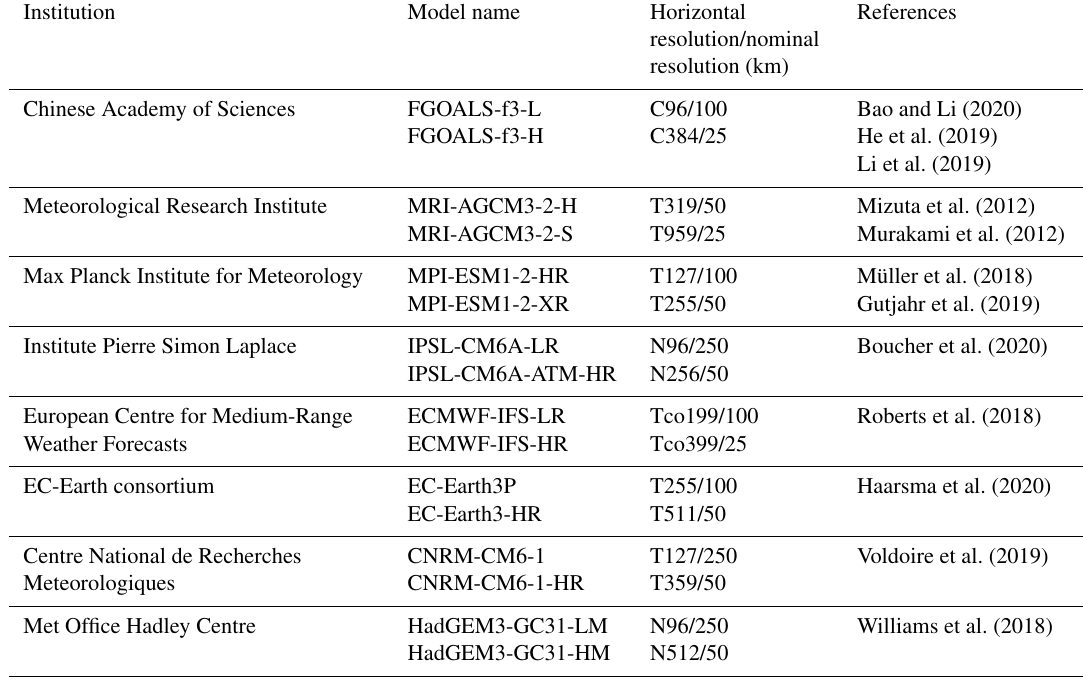
Table 6. Information about the GCMs participating in